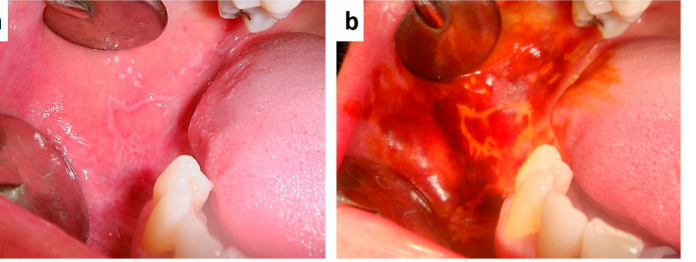
Figure 10. ( a , b ) The detection of an erythematous lesion with radiating white striae of the cheek ( a ), better highlighted by vital die with Lugol’s solution ( b ), is frequently the first clinical manifestation of a still undiagnosed discoid lupus erythematosus.